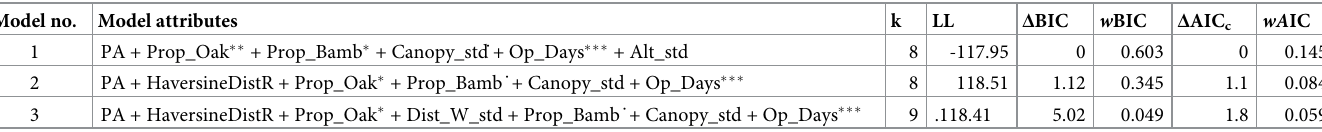
Table 2. The three most parsimonious generalized linear mixed-effects models representing the most influencing predictor variables based to wA IC and w BIC. Model no. Model attributes